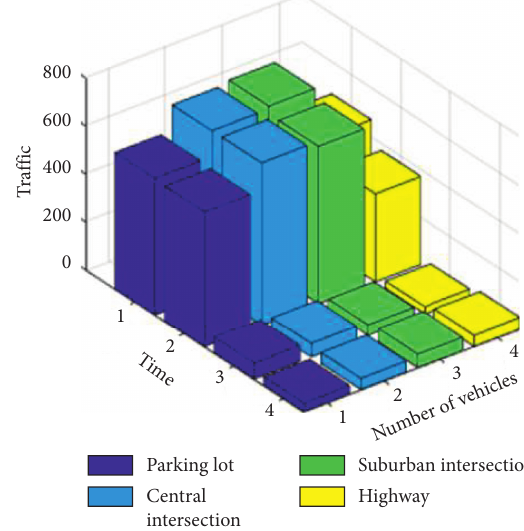
Figure 2: Traffic